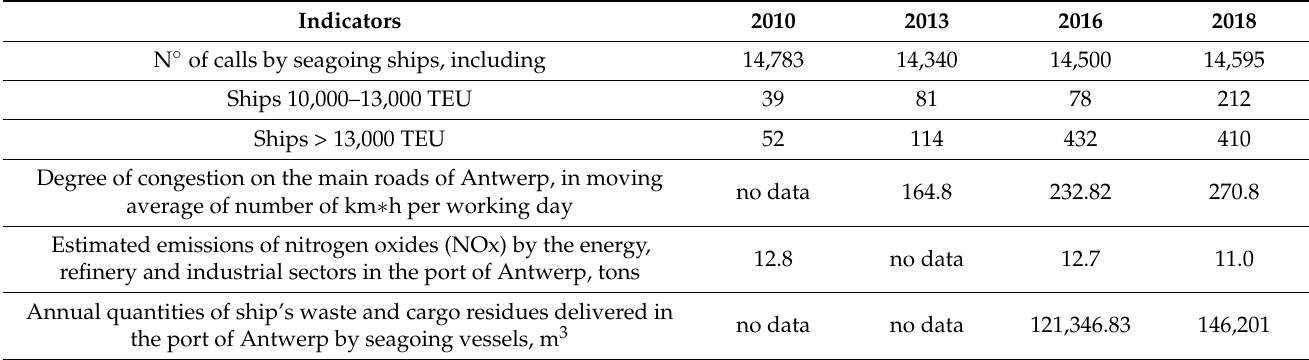
Table 4. The main indicators of sustainable development of the port of